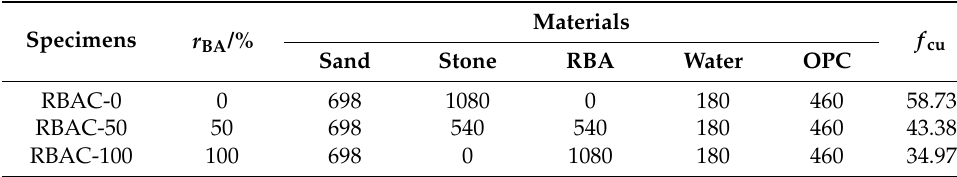
Table 4. The mix design for RBAC (kg · m − 3 ) and measured strength